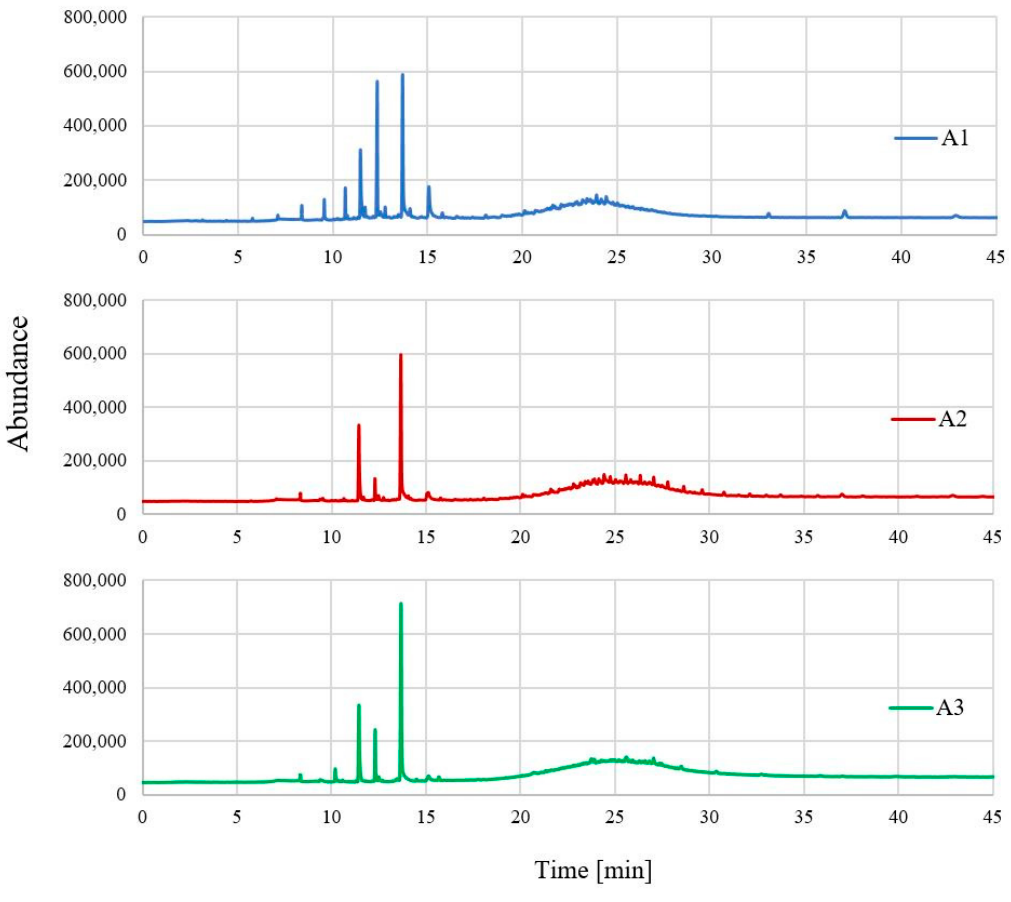
Figure 1. Chromatograms of commercial anti-caking preparations (A1, A2, A3). Table 3. Compounds identified in the tested anti-caking agents based on the NIST 14 MS library. Time Identified Compounds